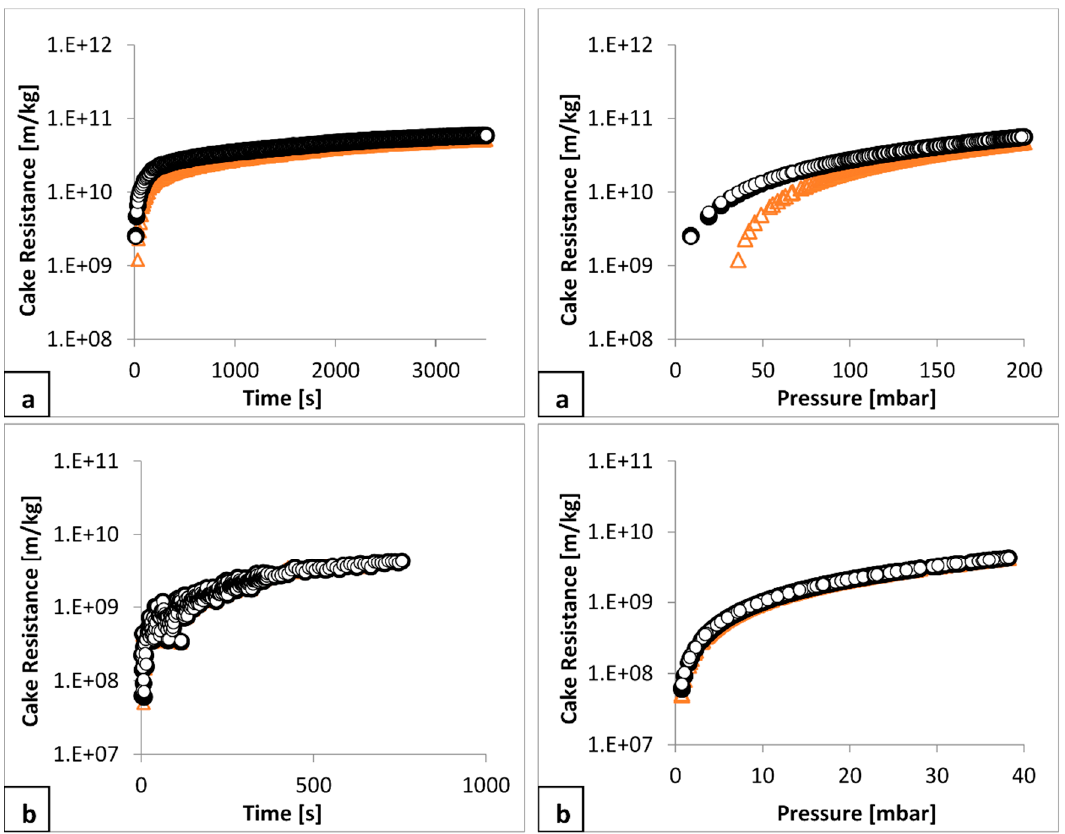
Figure 10. Comparison between calculated specific cake resistances using R m = 0 ( ○ ), R m = N 1 ( ● ) and R m = N 2 ( ∆ ), ( a ) for talc at 0.05 v / v and ( b ) for calcium carbonate at 0.21 v / v , both using a pump speed of 5 rpm.